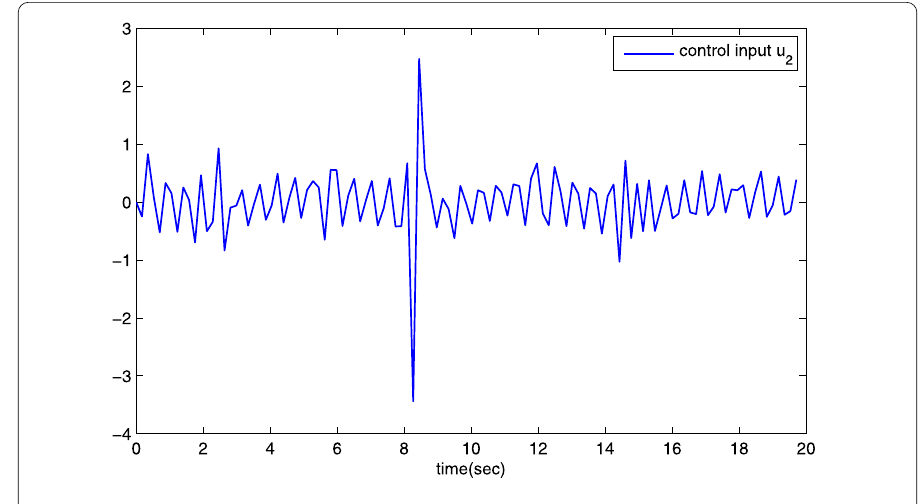
Figure 5 Responses of control input u 2 of example